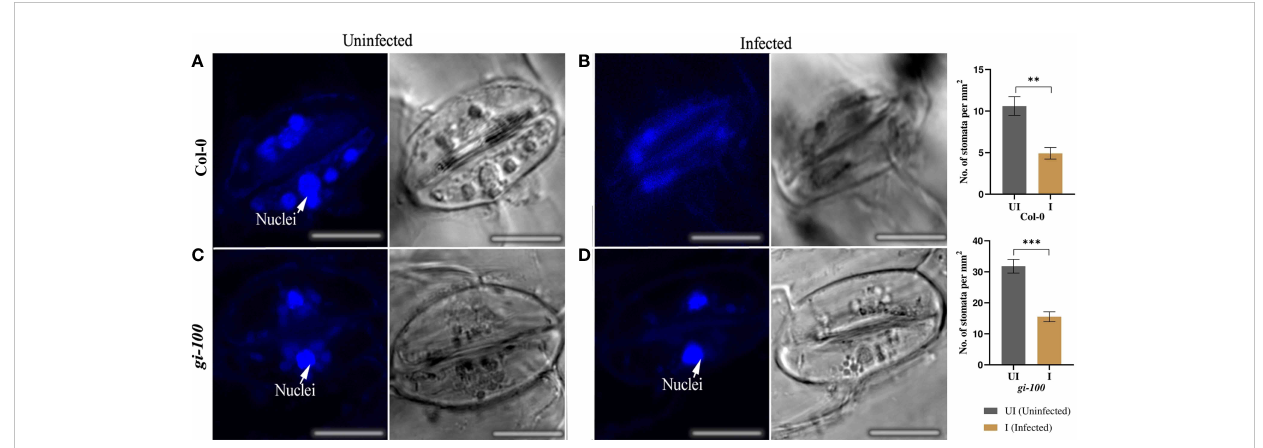
FIGURE 7 Effect of F. oxysporum infection on stomatal density and integrity in Col-0 and gi-100 plants. Concurrent confocal fl uorescence and transmitted light images of uninfected (A, C) and infected (B, D) Arabidopsis leaves at 9 DPI and labeled with DAPI stain for visualizing the nuclei. Nuclei are marked with arrows. Number of stomata was counted from the images taken during microscopy and calculated per unit area. Scale bar, 100 µm. Values in the graphs are expressed as mean ± SE. Two-way analysis of variance (ANOVA) using Sidak ’ s multiple comparisons test was performed with the help of GraphPad Prism to test for signi fi cance among the dataset,**p < 0.01, ***p < 0.001.